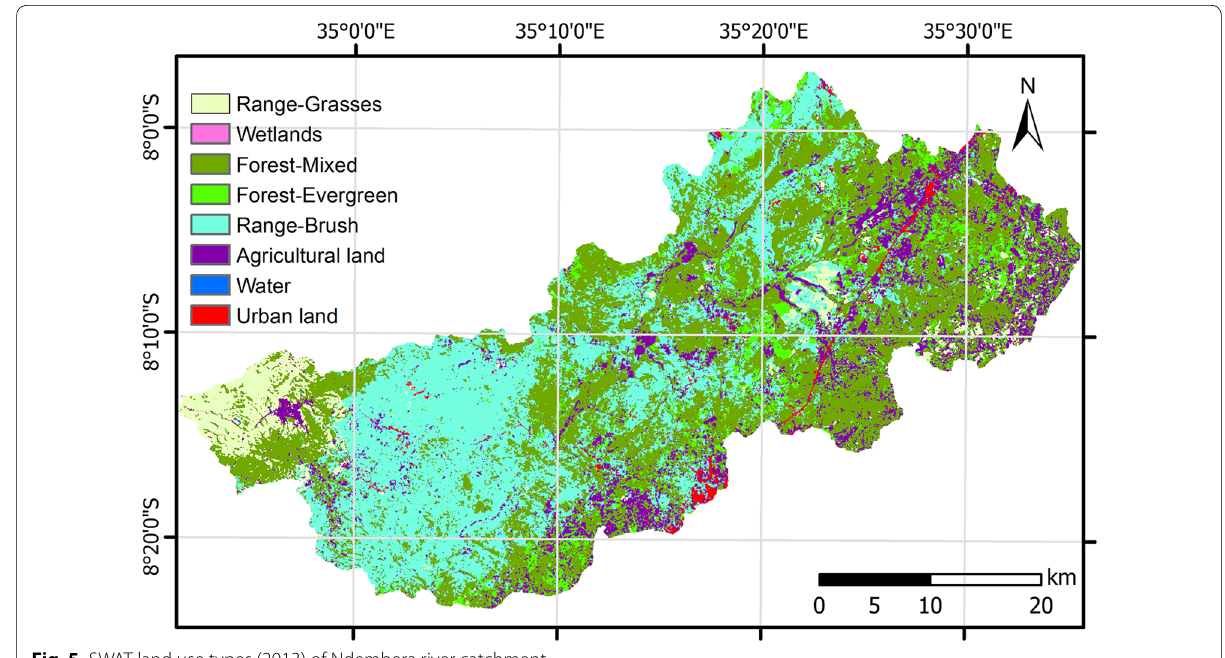
Fig. 5 SWAT land use types (2013) of Ndembera river catchment